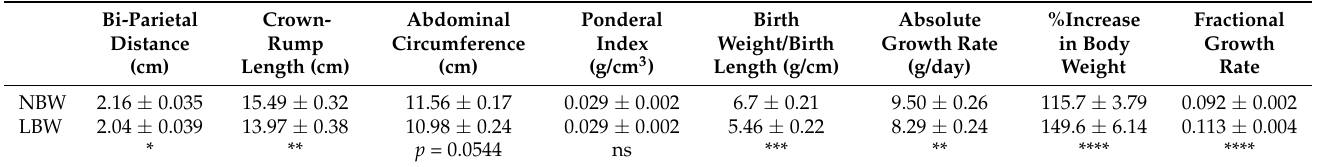
Table 1. Birth characteristics and lactation period